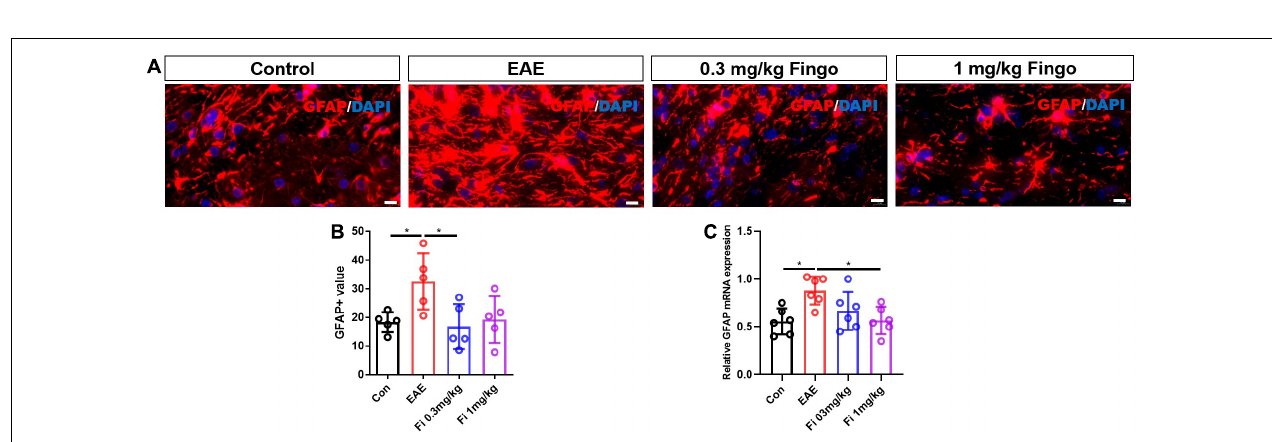
FIGURE 8 | Morphological and mean gray value changes of GFAP+ cells in the optic nerve. (A) Astrocytes labeled with GFAP with hypertrophy in EAE mice. (B) Comparison of the GFAP mean gray value among groups in the optic nerve. (C) GFAP mRNA expression in retina. Values are presented as mean ± SD. One-way ANOVA plus Tukey’s multiple comparisons. * P < 0.05, ** P < 0.01. Scale bar = 10 µ m.